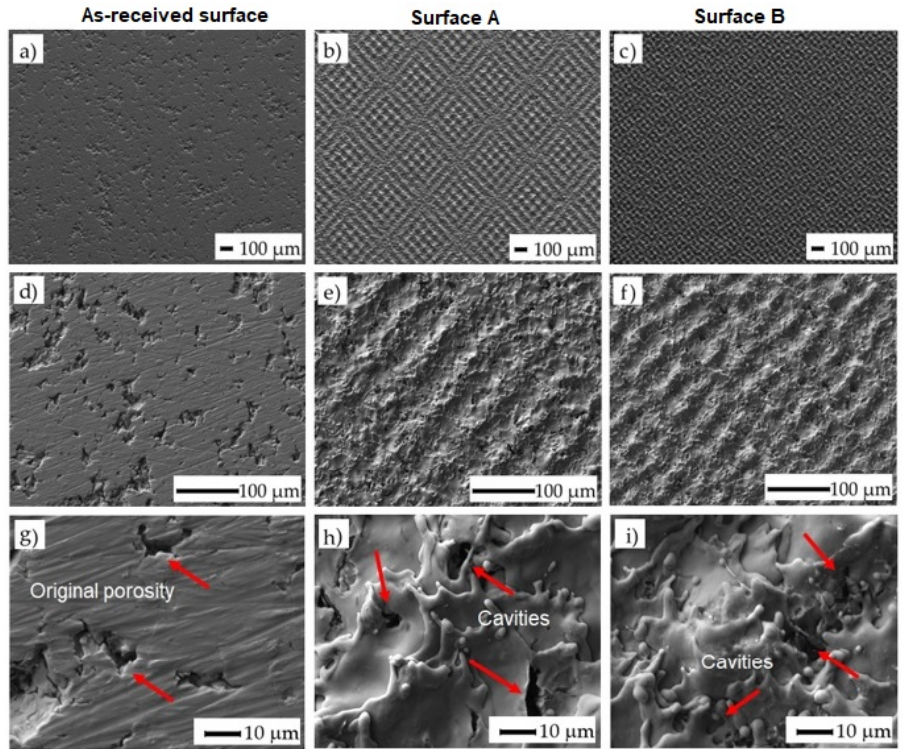
Figure 3. SEM images of treated surfaces: ( a ) as-received surface at a magnification of 50 × ; ( b ) surface A at ET of 0.5 mJ and at a magnification of 50 × ; ( c ) surface B at ET of 5 mJ and at a magnification of 50 × ; ( d ) surface before laser machining at a magnification of 250 × ; ( e ) surface A at ET of 0.5 mJ and at a magnification of 250 × ; ( f ) surface B at ET of 5 mJ and at a magnification of 250 × ; ( g ) surface before laser machining at a magnification of 1500 × ; ( h ) surface A at ET of 0.5 mJ and at a magnification of 1500 × ; ( i ) surface B at ET of 5 mJ and at a magnification of 1500 × . The arrows indicate the location where the cavities were formed. Table 3. Elemental composition of the as-received surface, Surface A and Surface B. Element (wt. %)